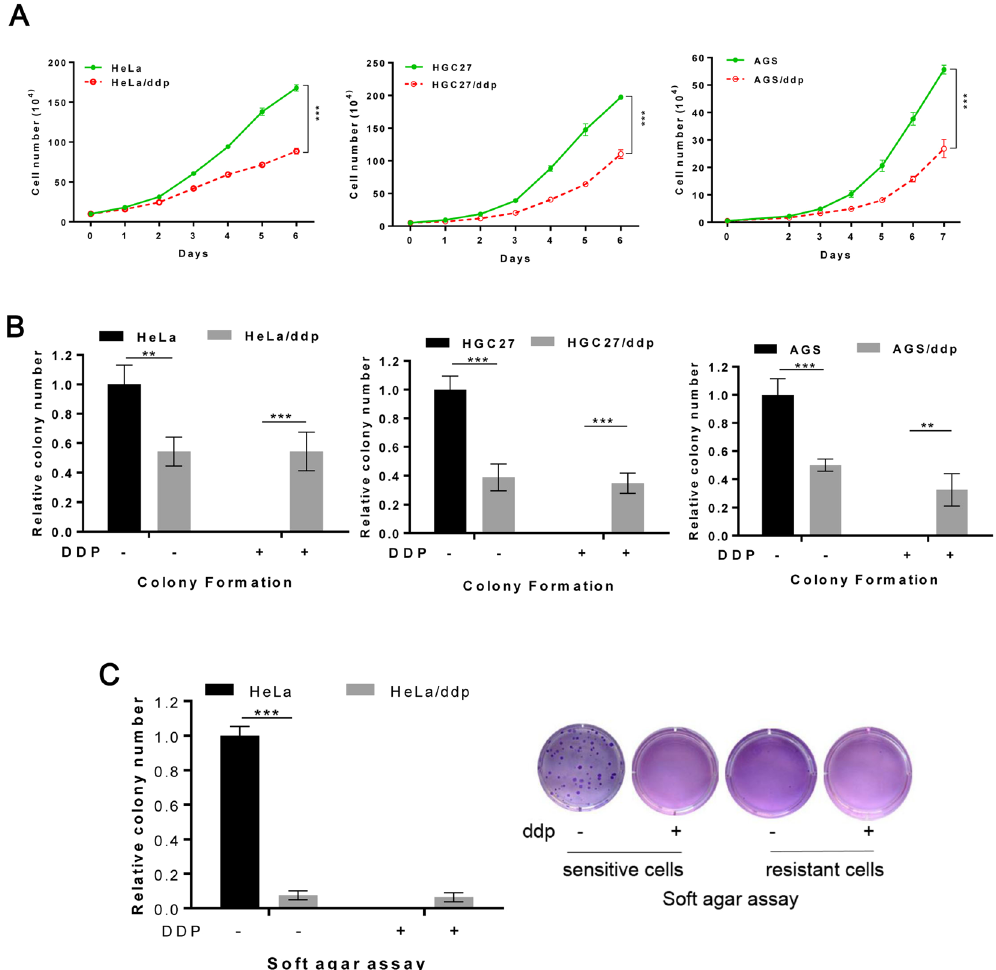
Figure 1. The growth of resistant cells is markedly slower than that of sensitive cells in vitro . ( A ) Growth of HeLa, HeLa/ddp, HGC27, HGC27/ddp, AGS and AGS/ddp cells; the medium was exchanged with normal medium every day. ( B ) Relative clonogenic growth of HeLa, HeLa/ddp, HGC27, HGC27/ddp, AGS and AGS/ ddp cells under the indicated conditions; ddp (0.5–0.7 μ g/ml) was added to the medium on the following day. ( C ) Soft agar assay of HeLa and HeLa/ddp cells under the indicated conditions. Cisplatin (0.5 μ g/ml) was added to the medium on the following day. The error bars represent the s.d. of triplicate wells of a representative